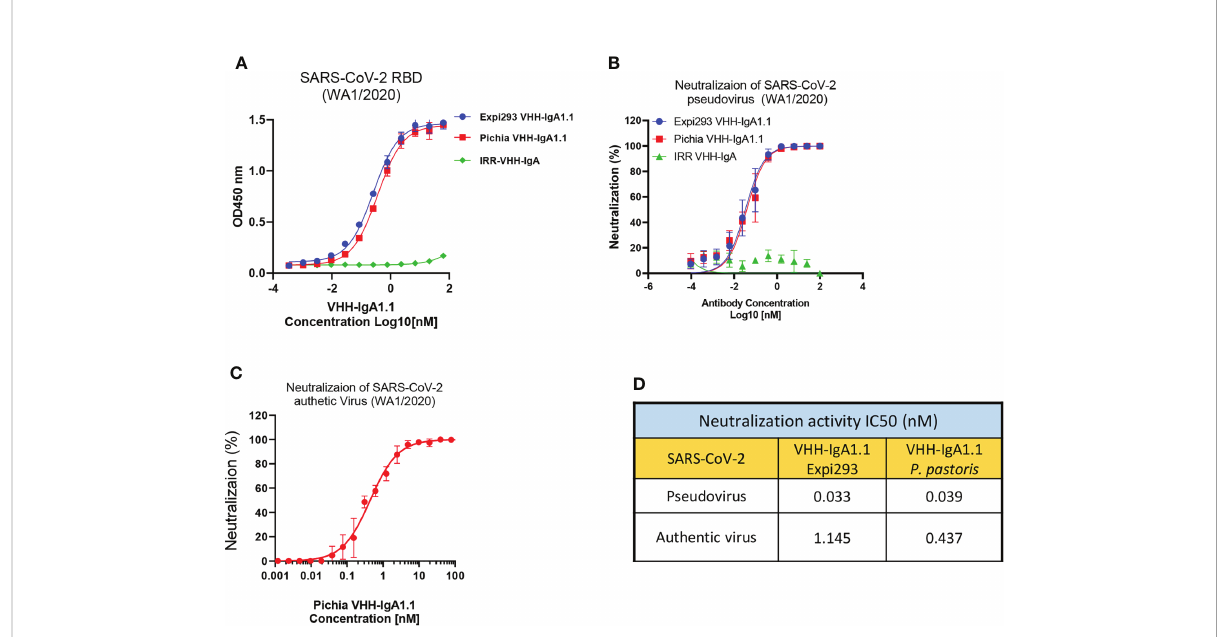
FIGURE 4 P. pastoris produced VHH-IgA1.1 exhibits potent activity against SARS-CoV-2. (A) Comparison of Expi293 cells and P. pastoris produced VHH- IgA1.1 binding to SARS-CoV-2 RBD in ELISA. (B) Comparison of Expi293 cells and P. pastoris produced VHH-IgA1.1 mediated in vitro neutralization of luciferase-encoding pseudovirions with full length spike proteins presented in SARS-CoV-2 WA1/2020 strain. (C) Dose- Response Curve generated from PRNT of P. pastoris produced VHH-IgA1.1 against authentic SARS-CoV-2 on Vero E6 cells. (D) Data was plotted as the average ± SD, and IC 50 values were calculated by nonlinear regression analysis. Three or more independent biological replicates were completed for each